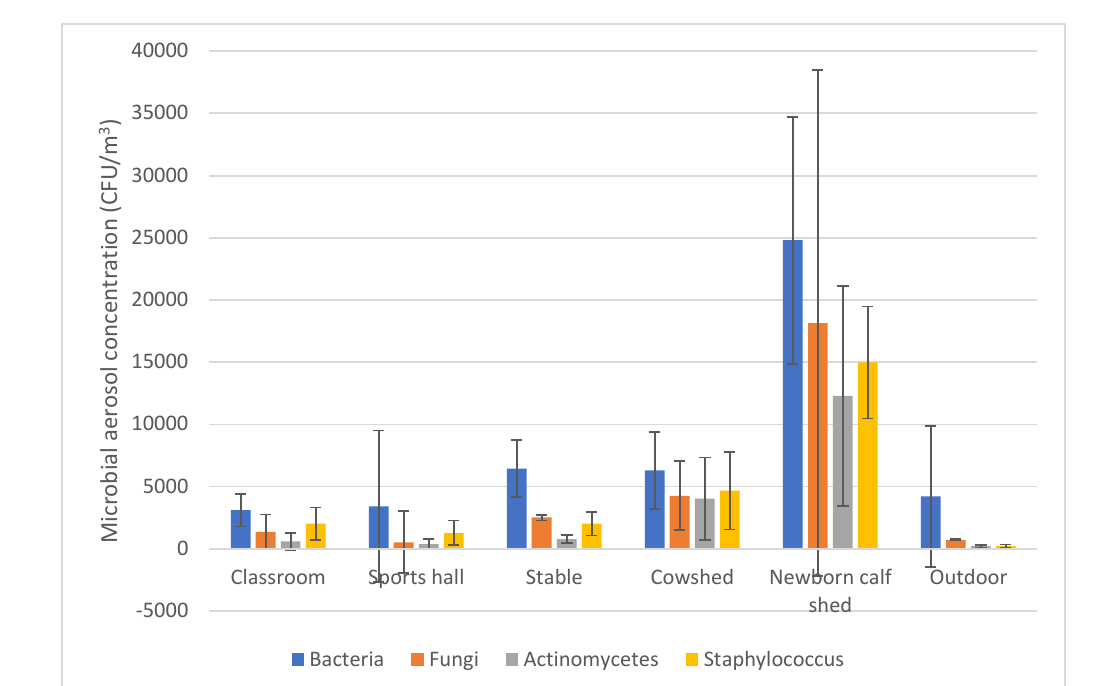
Figure 3. Mean concentration of microbial aerosol (CFU/m 3 ) in the examined sites. Bars represent standard deviations.